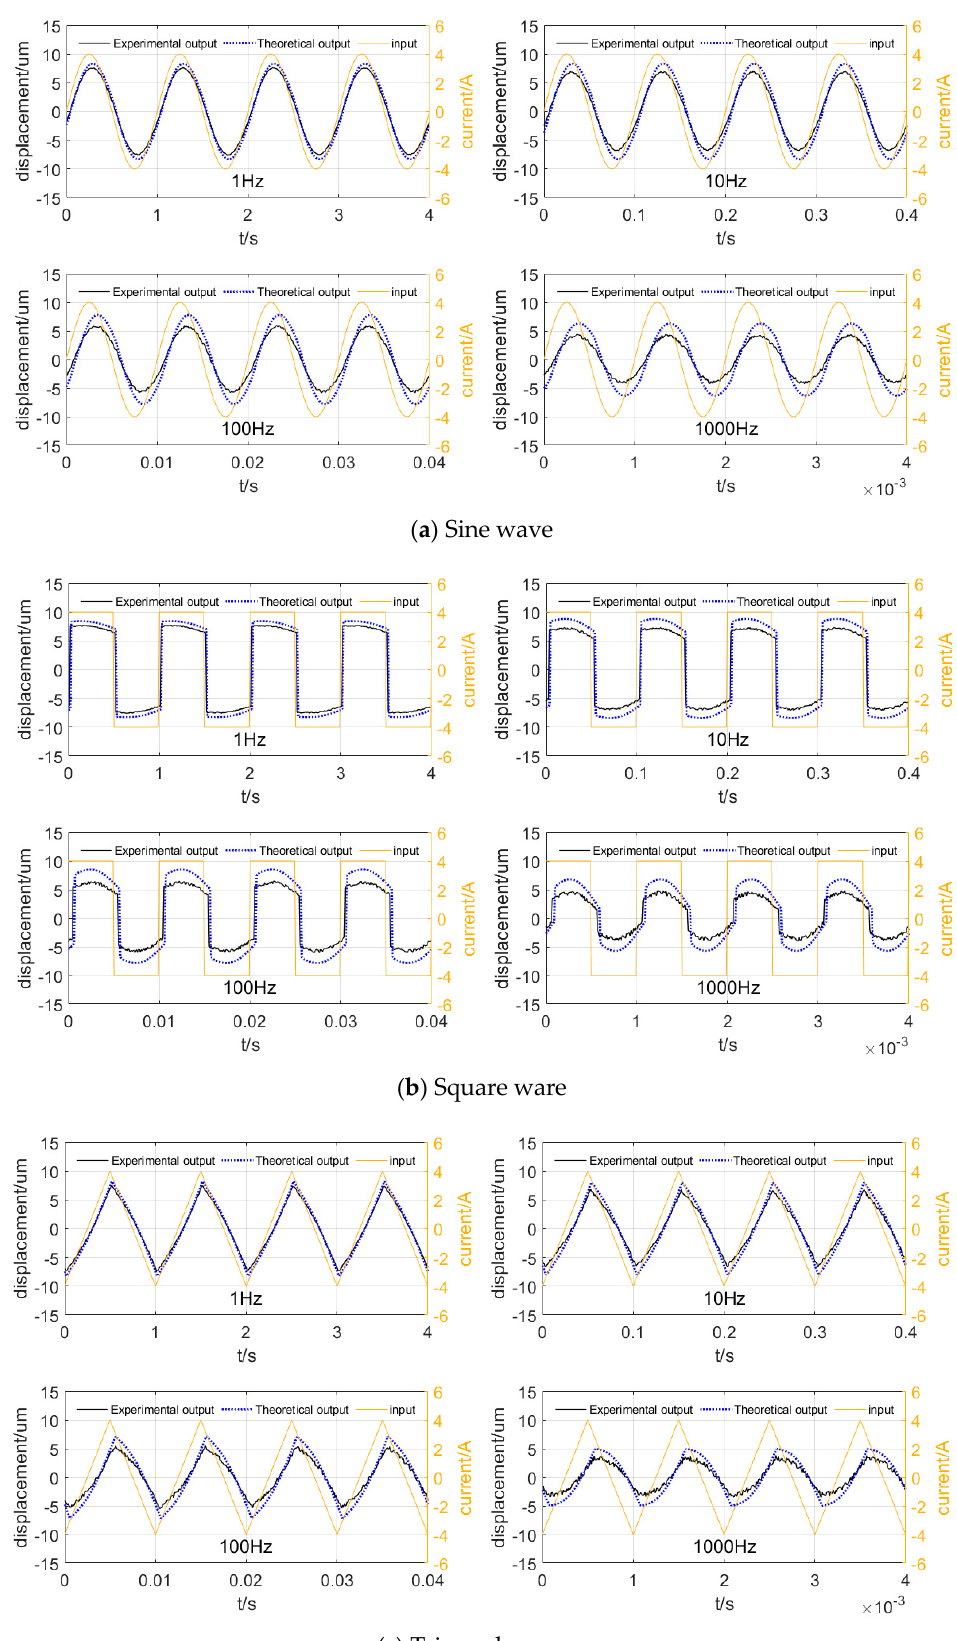
Figure 13. Results of SGMA output experiment.